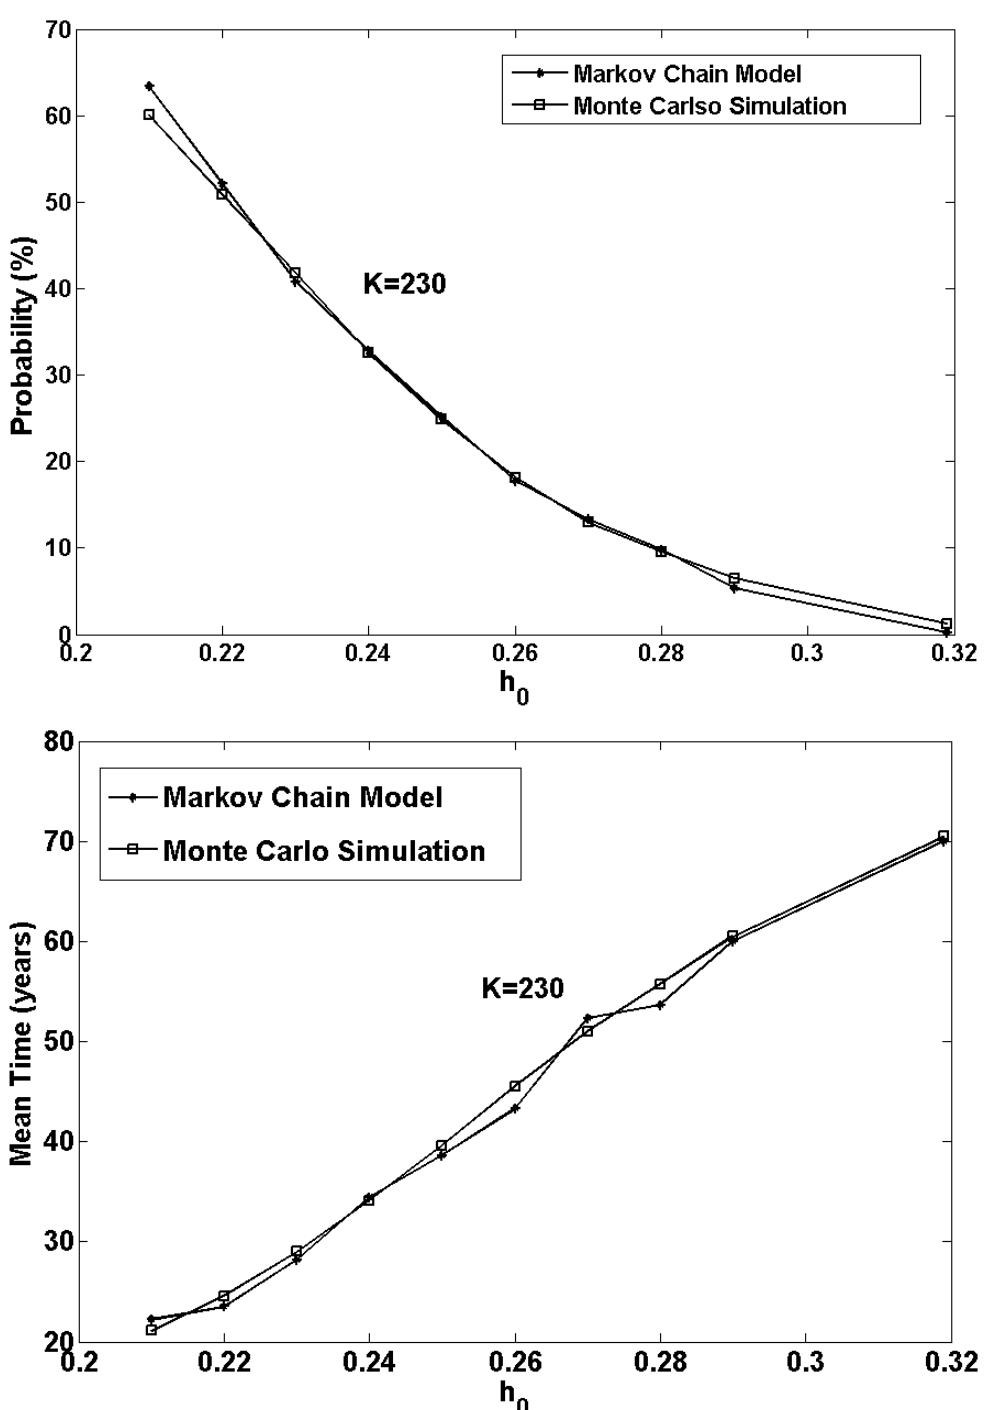
Fig. 4 – Comparison between the estimates using Markov chain and Monte Carlo